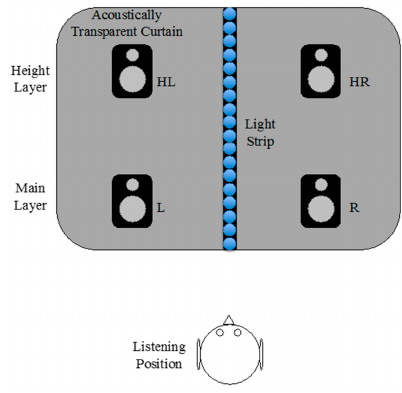
Figure 8. Physical setup for the localisation threshold verification